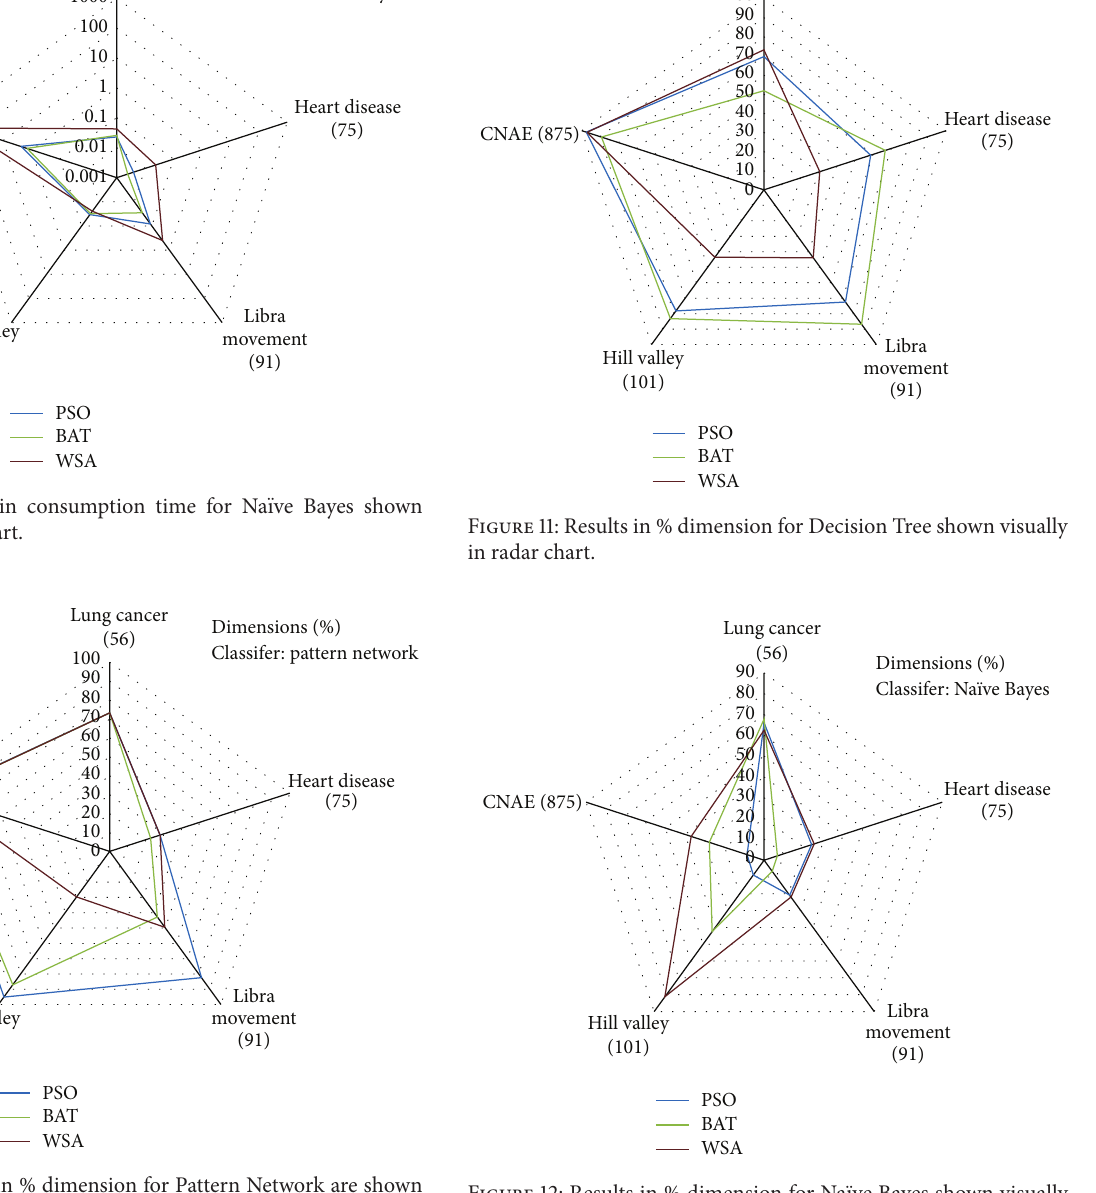
Figure 12: Results in % dimension for Na¨ıve Bayes shown visually in radar